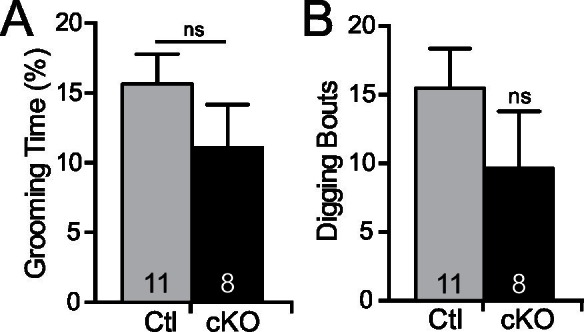
Mef2c cKO mice do not exhibit repetitive grooming or digging.(A) No difference in time spent grooming is observed in Mef2c cKO mice compared to controls. (B) No difference in the number of digging bouts was observed between control and Mef2c cKO mice. Data are represented as mean ± SEM. Statistical significance was determined by unpaired t-test. ns=not significant. Numbers of animals (n) are reported in each bar for respective experiment.